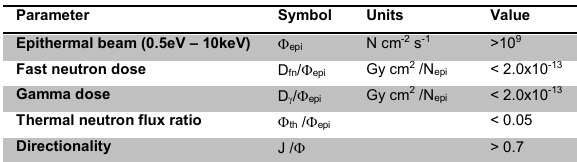
Table 2. IAEA recommendations for a BNCT neutron